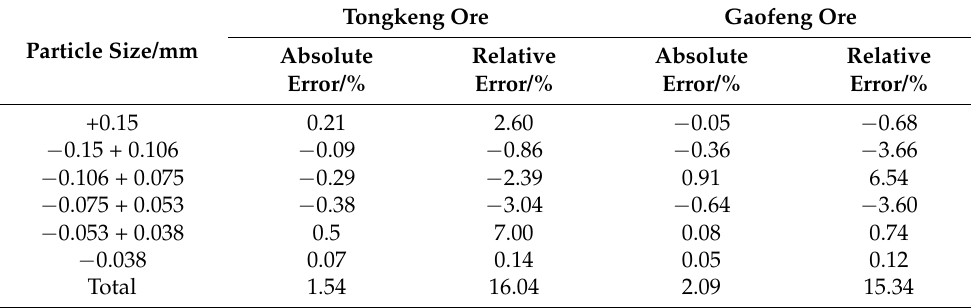
Table 10. Error comparison of Tongkeng ore and Gaofeng ore.